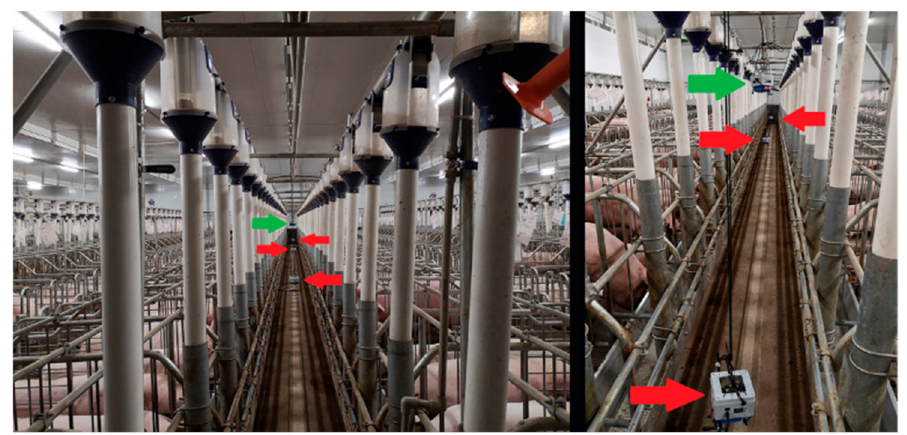
Figure 5. Positioning of the slave nodes in different heights (green arrows indicates nodes at a height of 150 cm, red arrows a height of 60